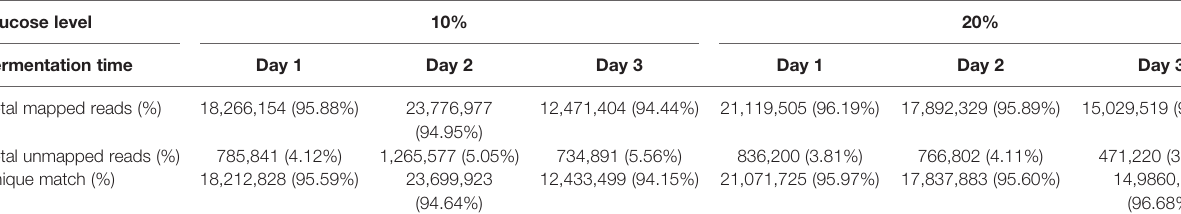
TABLE 1 | Summary of the read-mapping statistics on the transcriptomic features of B. bassiana liquid cultures grown over time. Glucose level